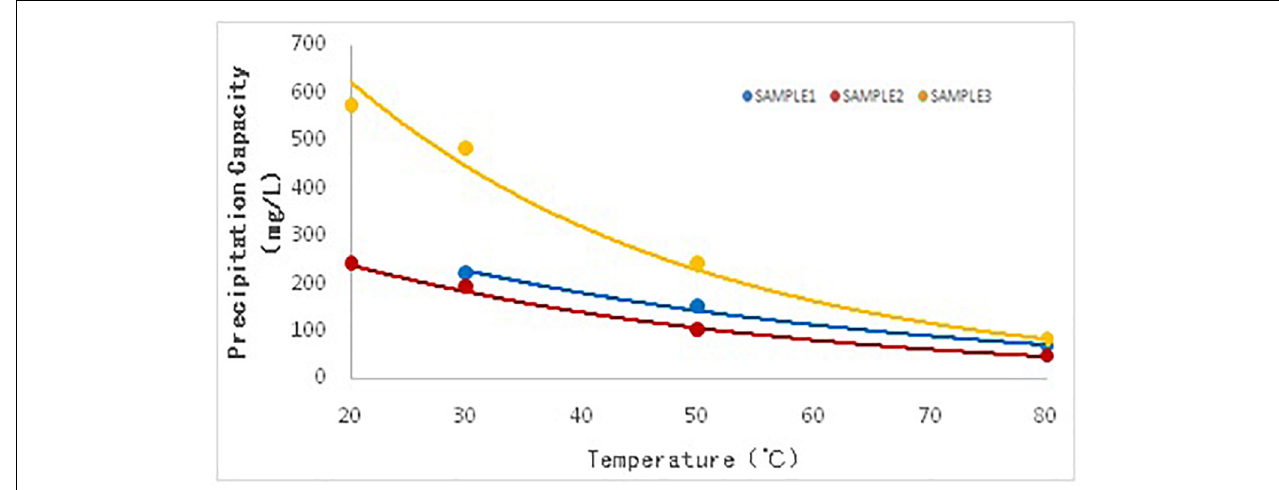
FIGURE 3 | The relationship between temperature and the precipitation capacity of inorganic